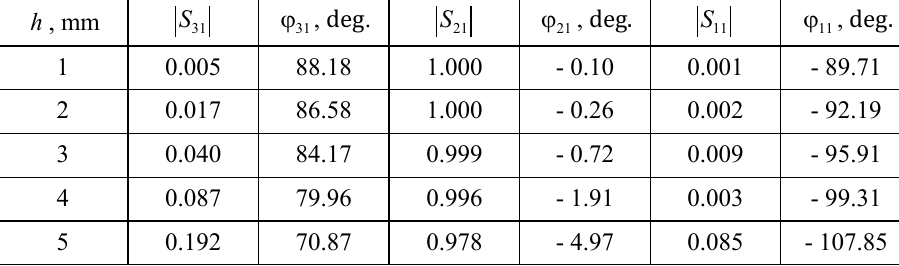
Table 1 . Parameters of the elements of the scattering matrix of an omnidirectional probe at various immersion